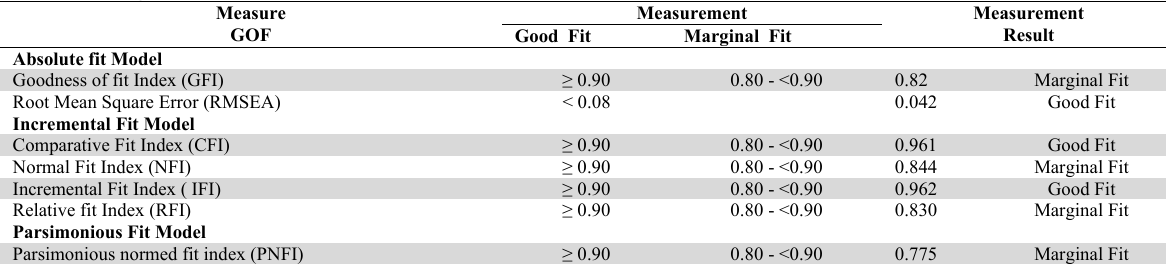
The results of goodness of fit